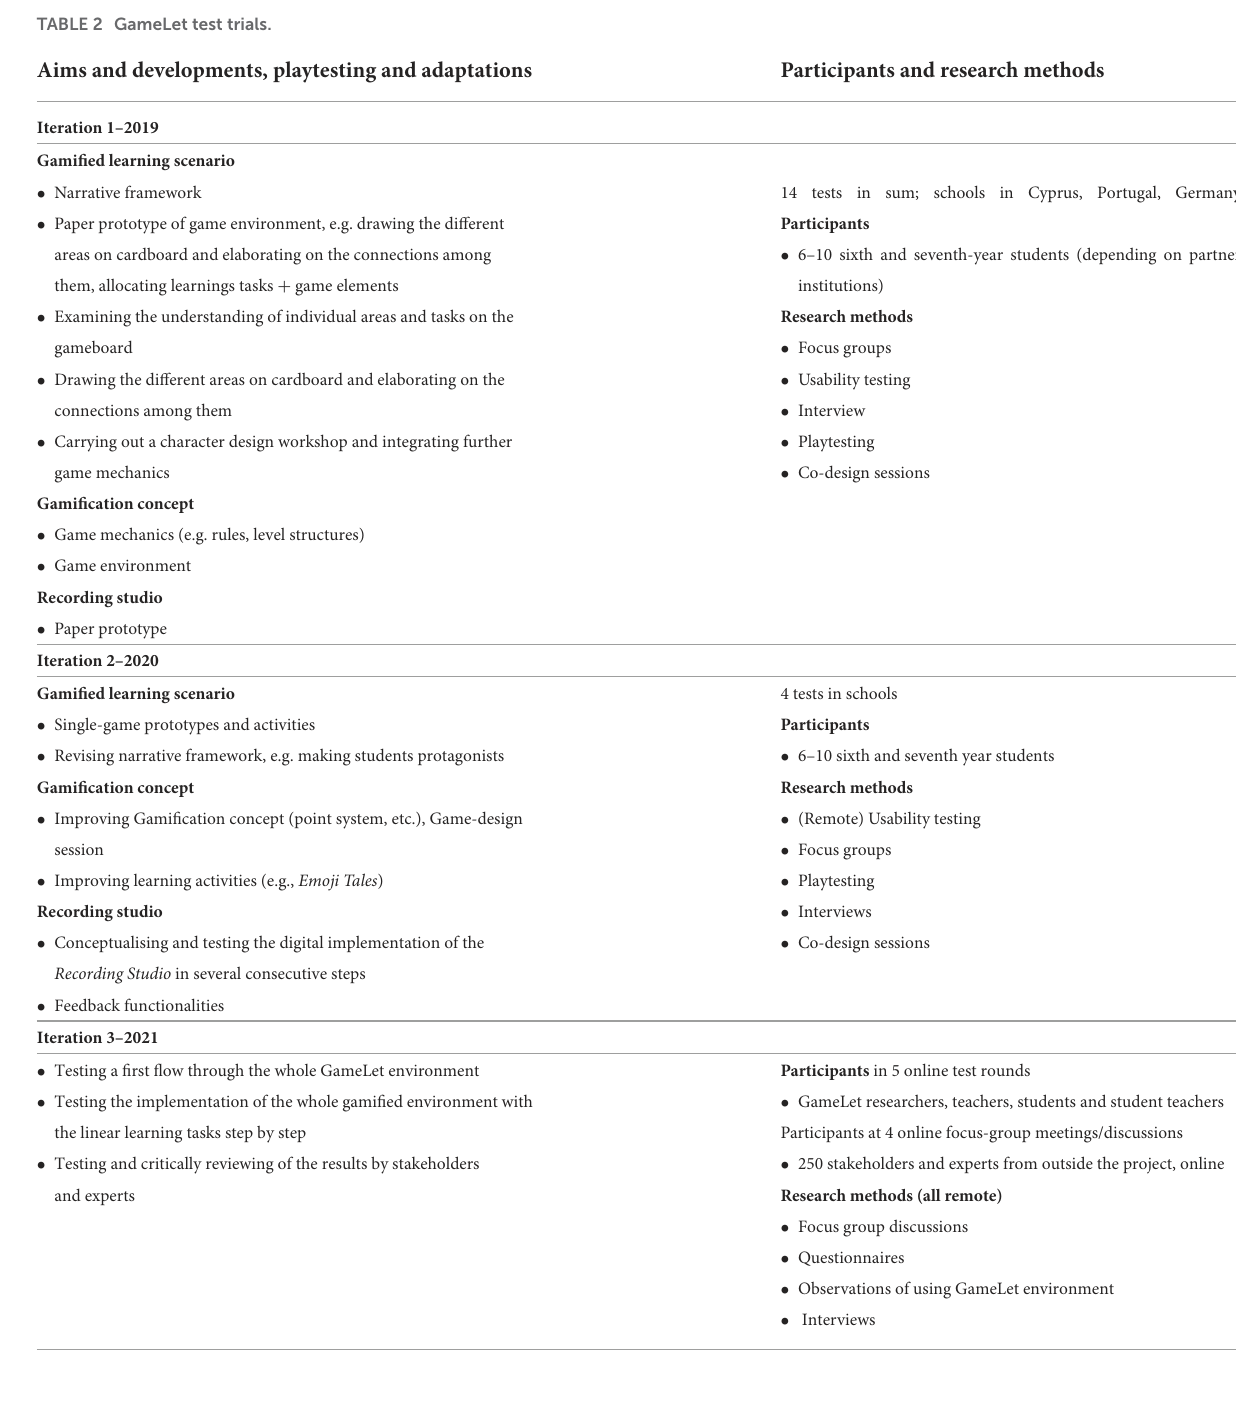
TABLE 2 GameLet test